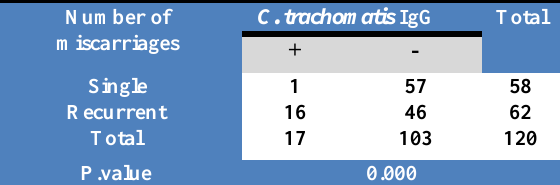
Table, 5: The Association between IgG and the number of